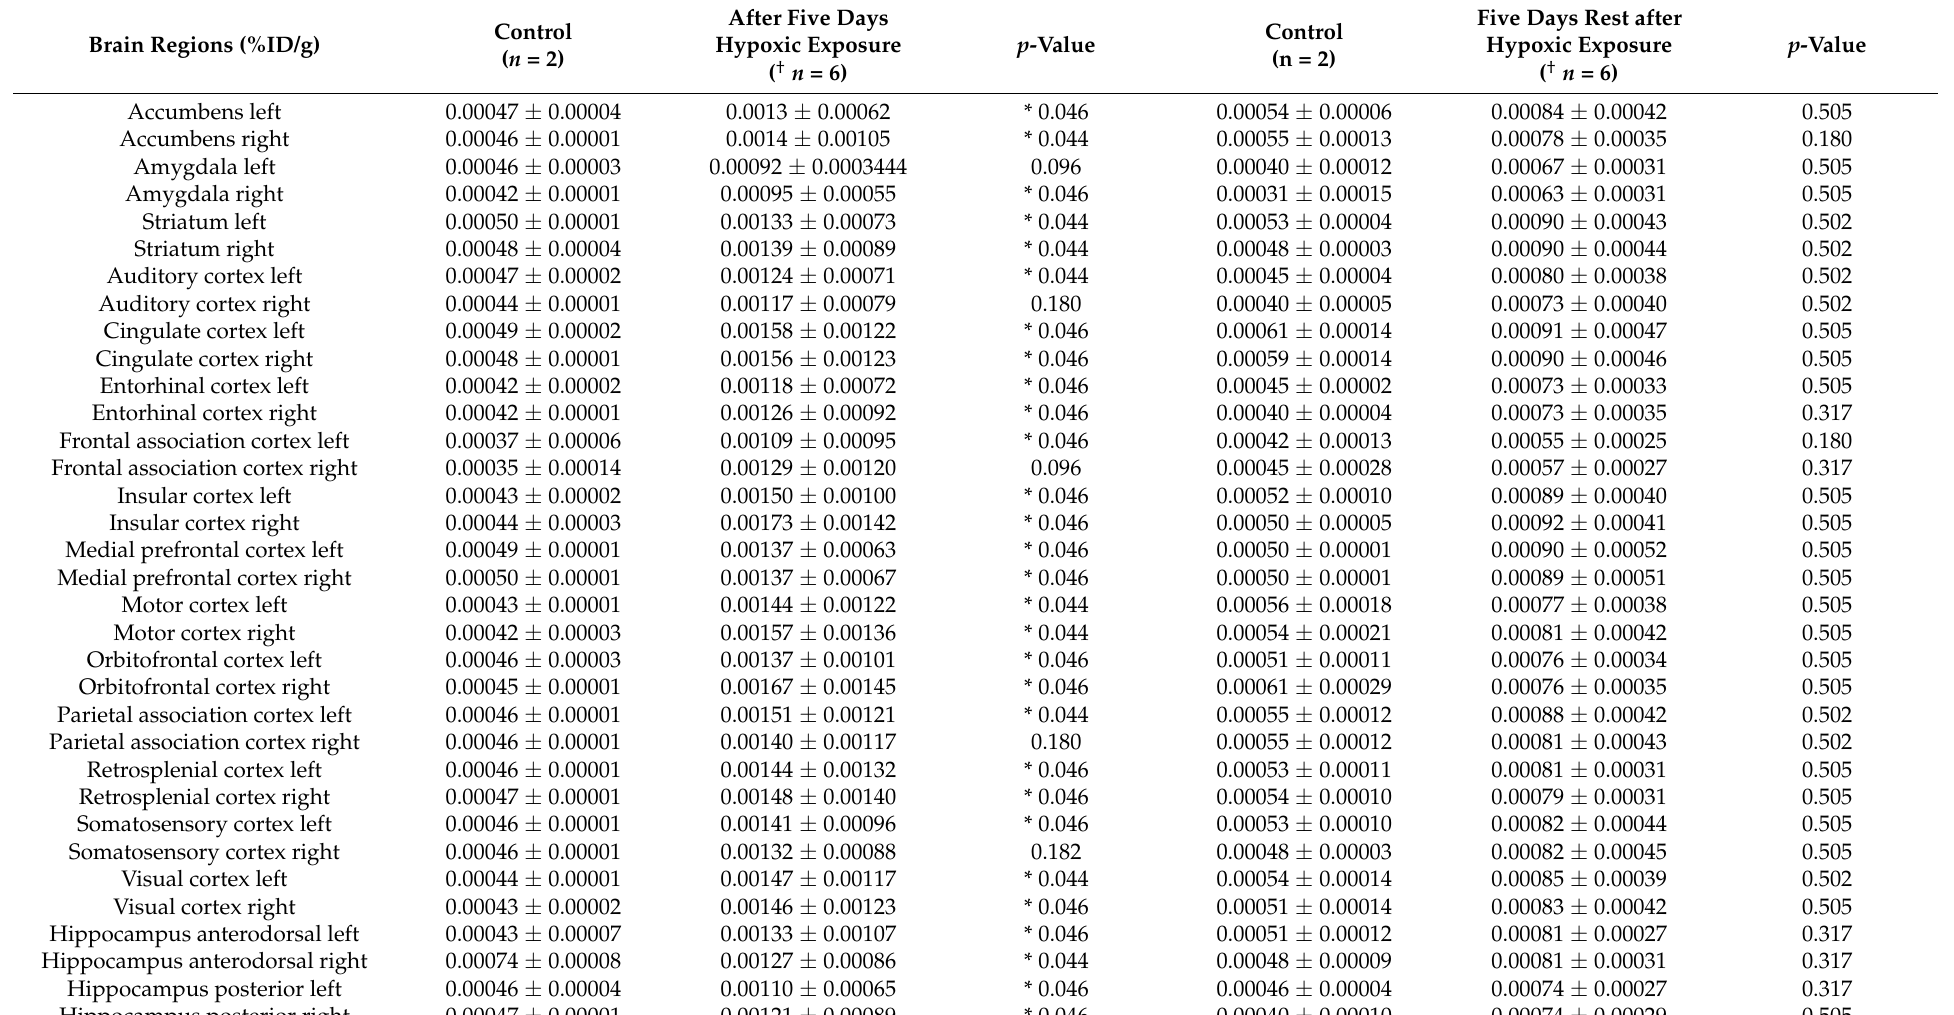
Table 1. Association of brain region with hypoxic exposure